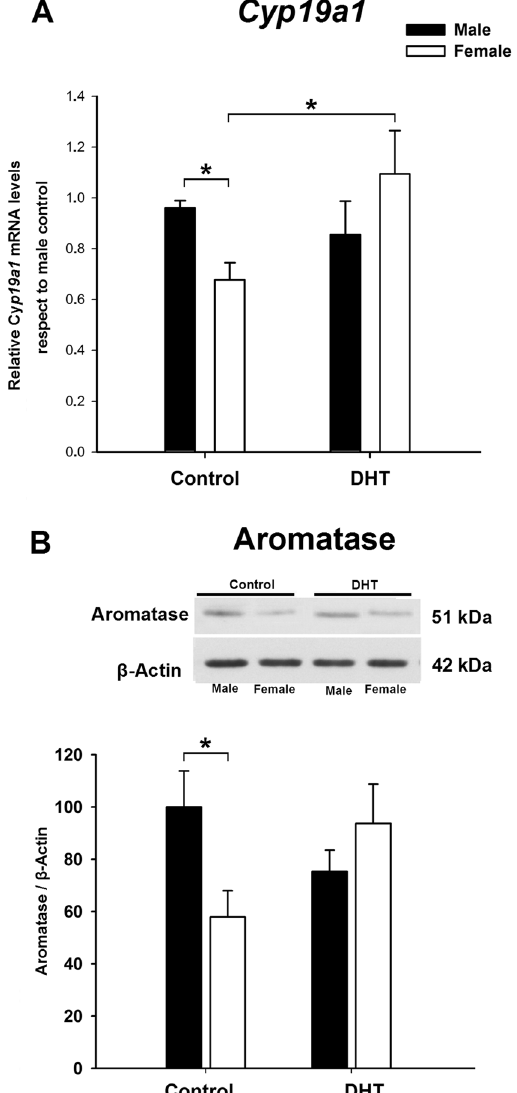
Figure 4. Effect of dihydrotestosterone (DHT) on aromatase mRNA ( Cyp19a1 , A ) and protein ( B ) in male and female primary amygdala neuronal cultures from CD1 mouse embryos. DHT stimulation increased aromatase mRNA levels in females but not in male cultures. * p ≤ 0.05. Bars indicate mean + SEM. n = 4–6 independent